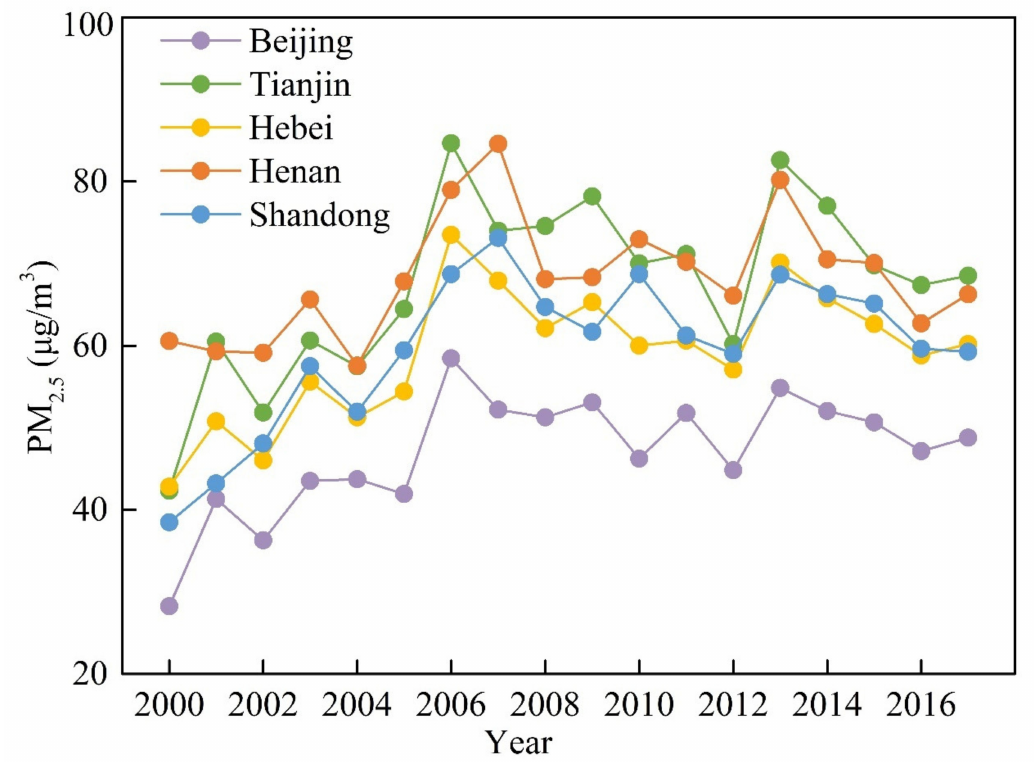
Figure 5. Temporal variations of PM 2.5 concentrations from 2000–2017 (data source: http://fizz.phys.dal.ca/~atmos/ martin/) (accessed on 15 March